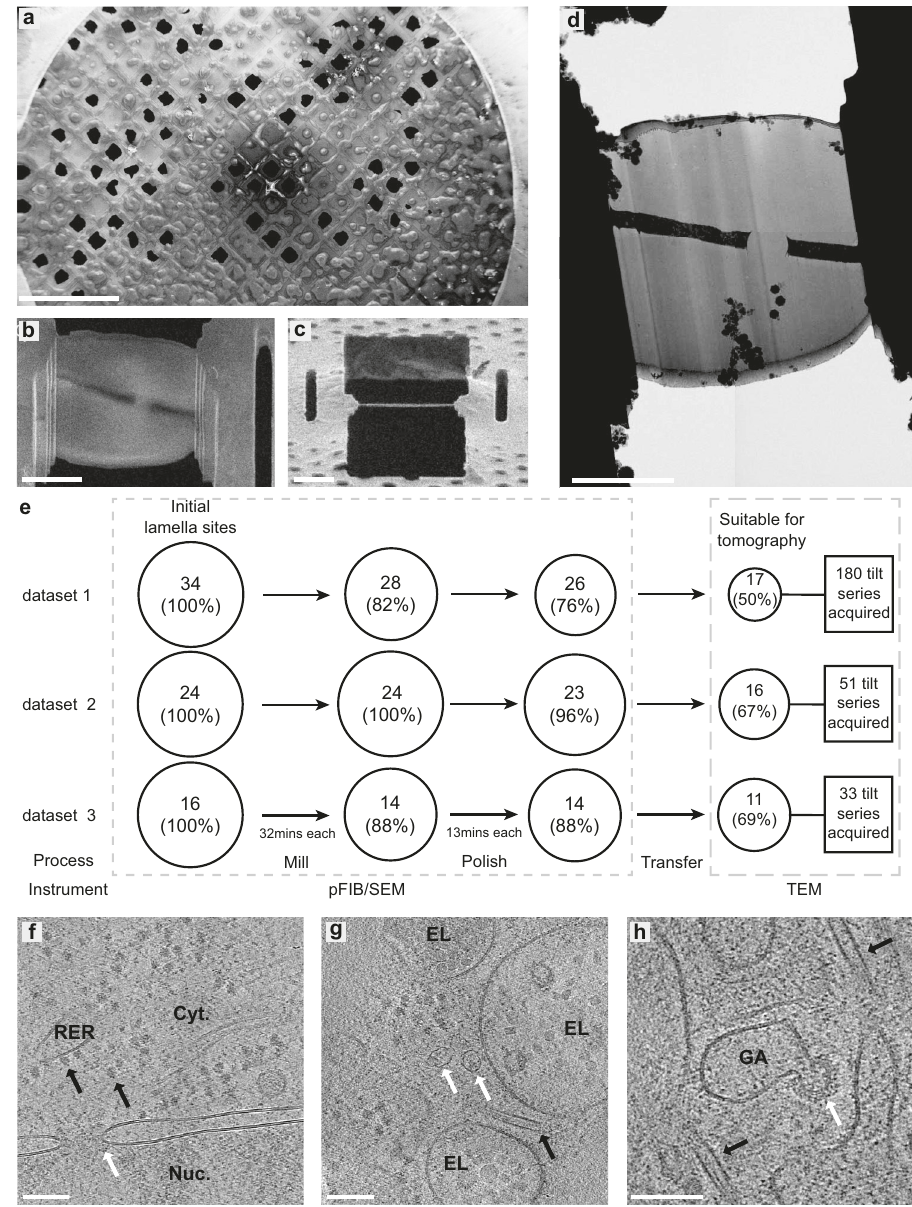
Fig.1|OverviewoflamellaproductionusingplasmaFIBmilling.a SEMoverview of a representative uncoated grid (cells were grown on UltraAuFoil (Quantifoil) grids) from three independent plasma FIB milling sessions. b Representative SEM image of a fi nished lamella and c its respective PFIB image. d Low magni fi cation TEMimageofthesamelamella.Scalebarare500 µ min a and5 µ min b , c and d